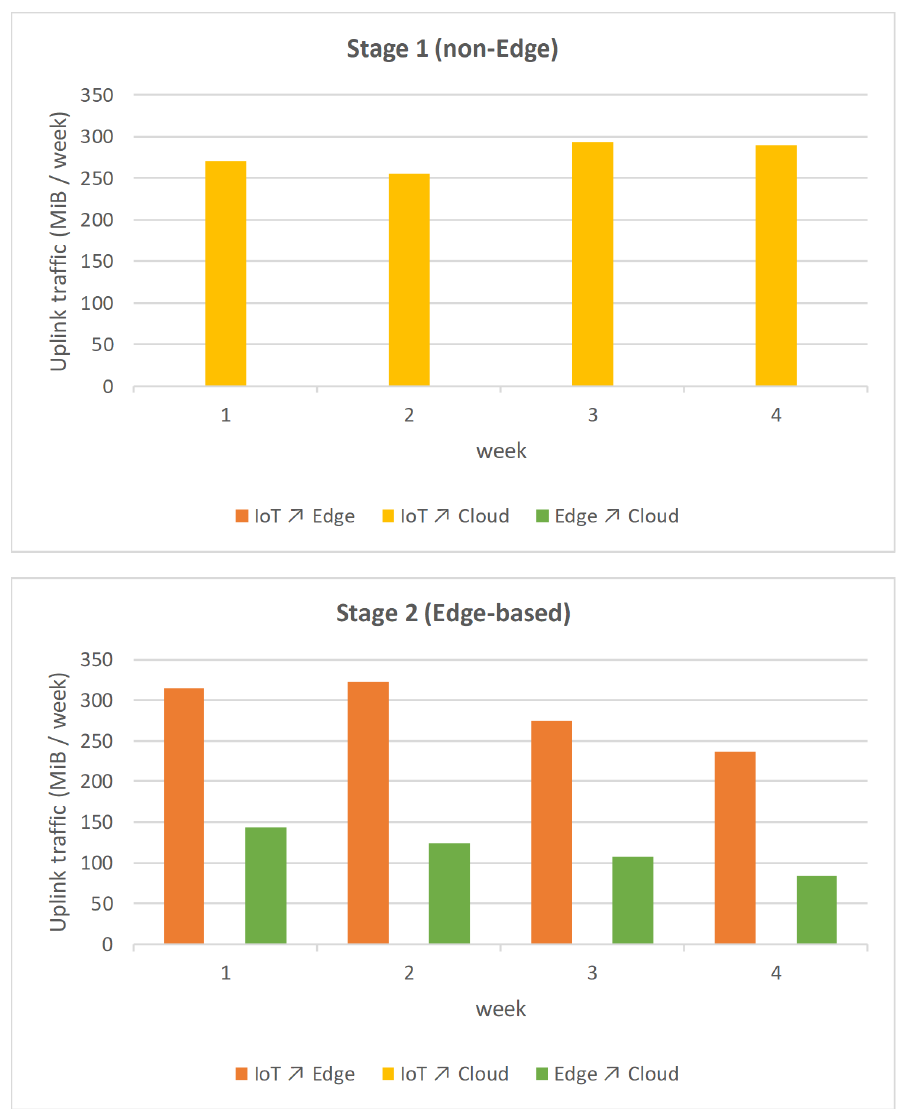
Figure 7. Comparison of the amount of data transferred in the two tests